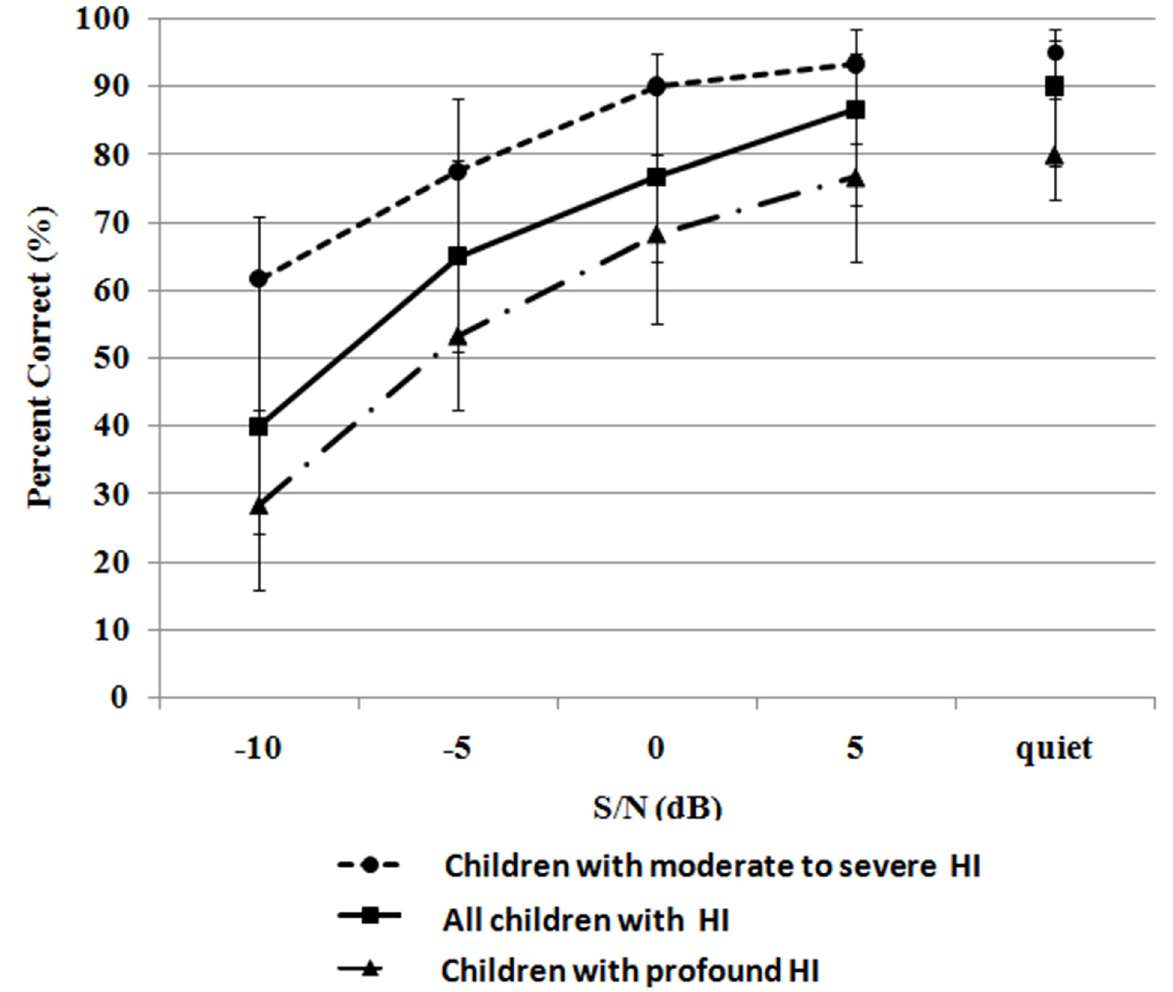
Fig 3. Median tone identification scores measured on the MTIT in quiet and in four noise conditions. The error bars denote interquartile range.